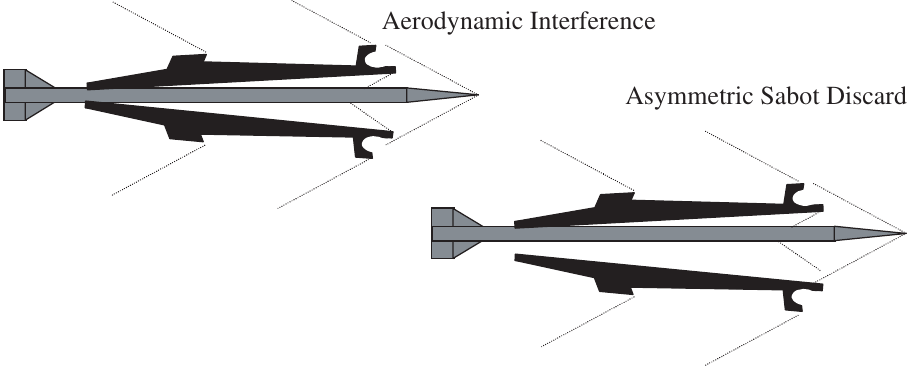
Fig. 5. Sabot discard components of